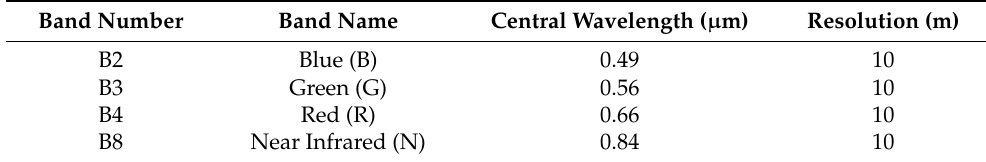
Table 1. Sentinel-2 data used for